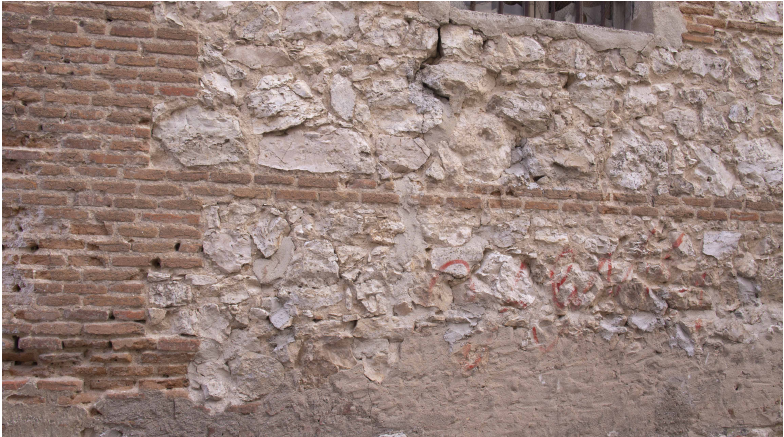
Figure 8. Photograph taken by visible spectrum